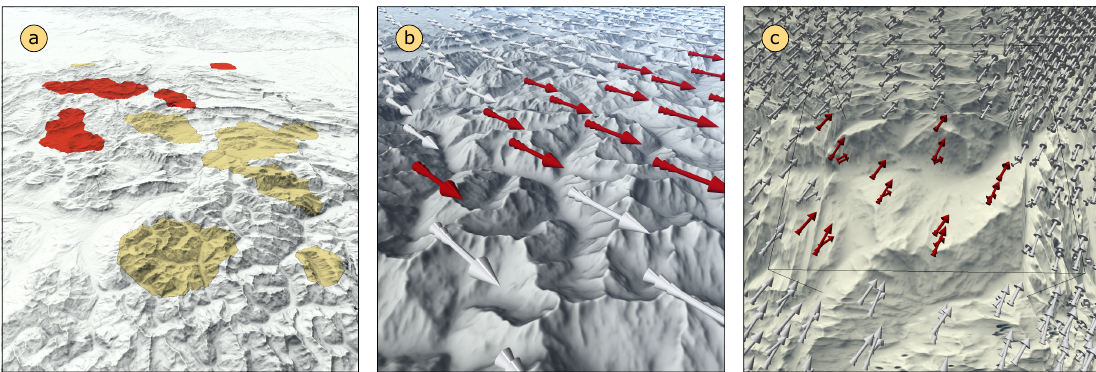
Figure 8. Emphasizing data features. ( a ) shows a visualization of thunderstorm cells. Emerging thunderstorm cells with hazardous potential are highlighted using red color. ( b ) and ( c ) show wind glyphs that encode wind direction (arrow head) and strength (length of the arrow). In ( b ), strong wind conditions are highlighted using a prominent color for corresponding wind glyphs. In ( c ), local features are emphasized by distortion: the framed area is magnified to better observe details of the wind